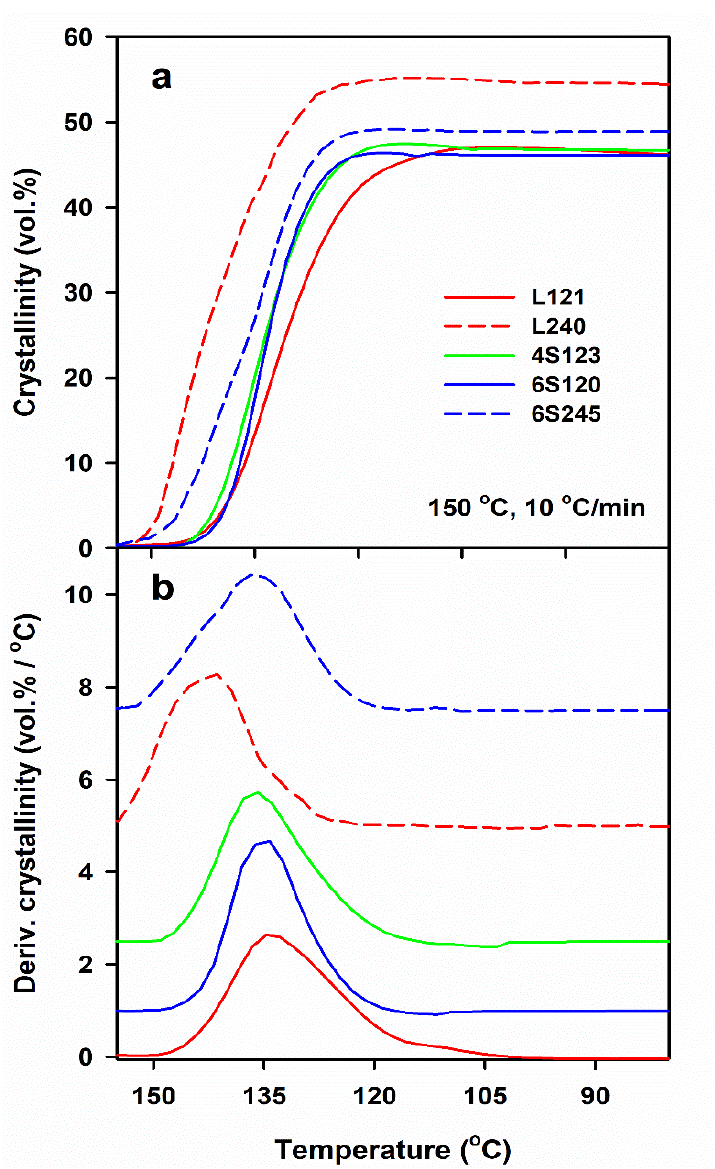
Figure 3. Development of crystallinity determined by light depolarization method ( a ) and derivative of crystallinity with respect to temperature ( b ) in PLLAs during cooling at 10 °C/min after shearing at 20 /s, 150 °C. The curves in Figure 3b shifted vertically for clarity.